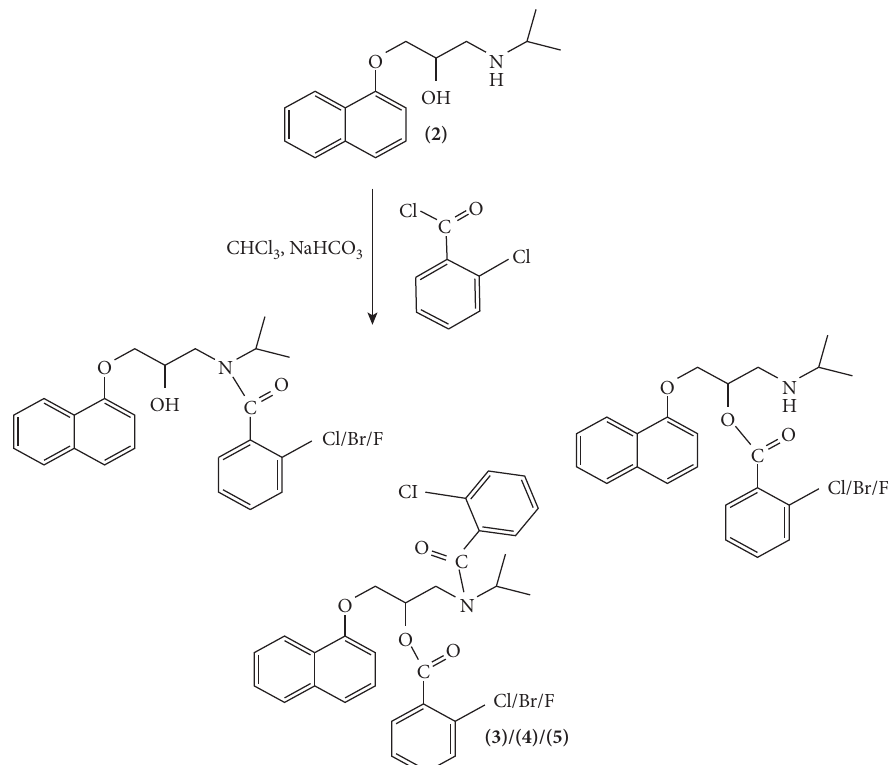
Figure 3: The scheme describes the synthesis of propranolol with (i) 2-chlorobenzoyl chloride; (ii) 2-bromobenzoyl chloride; (iii) 2-flourobenzoyl chloride, at conditions of CHCl 3 and NaHCO 3 at 50 ° C for 24 h.